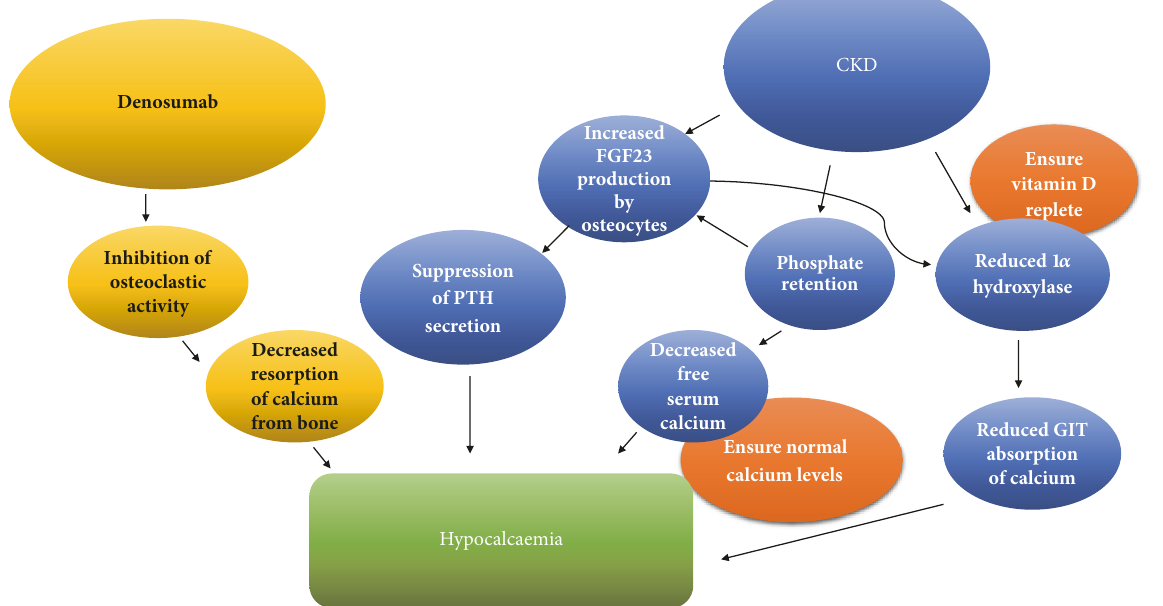
Figure 2: A summary of mechanisms for increased risk of hypocalcaemia with denosumab in patients with